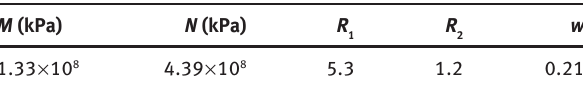
Table 1: Parameters of the explosive used in the Jones-Wilkins-Lee model.